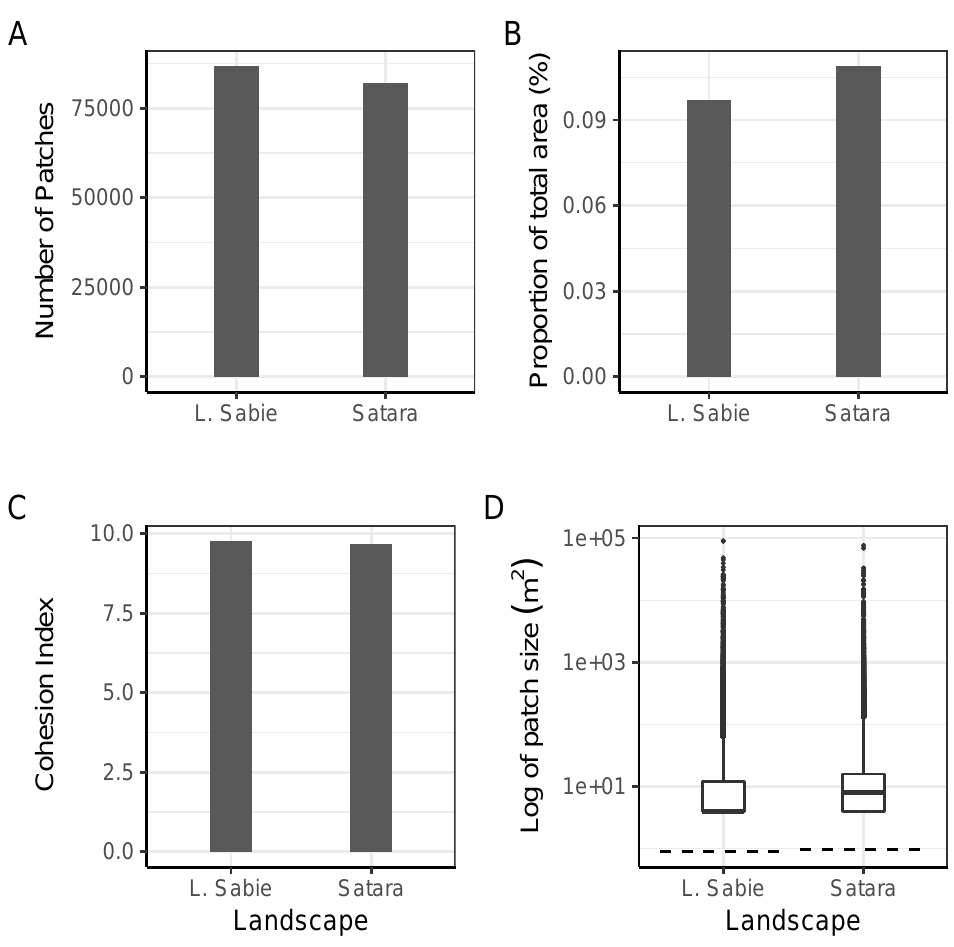
Figure 9. Landscape-scale summary of grazing lawn spatial characteristics. ( A ) Number of grazing lawn patches; ( B ) Proportion of total landscape covered by grazing lawns; ( C ) Physical connectedness of grazing lawn patches; ( D ) Distribution of grazing lawn patch size. Dashed horizontal line represents mean patch